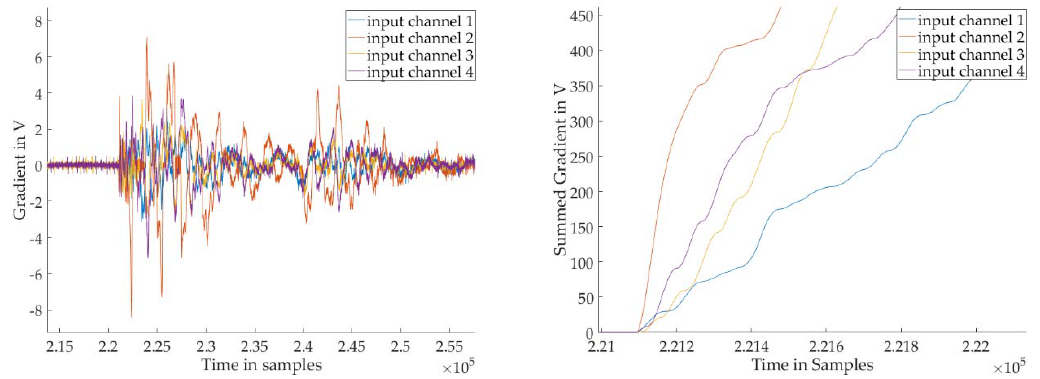
Figure 9. Example of calculated gradient ( left ) and summed gradient ( right ).